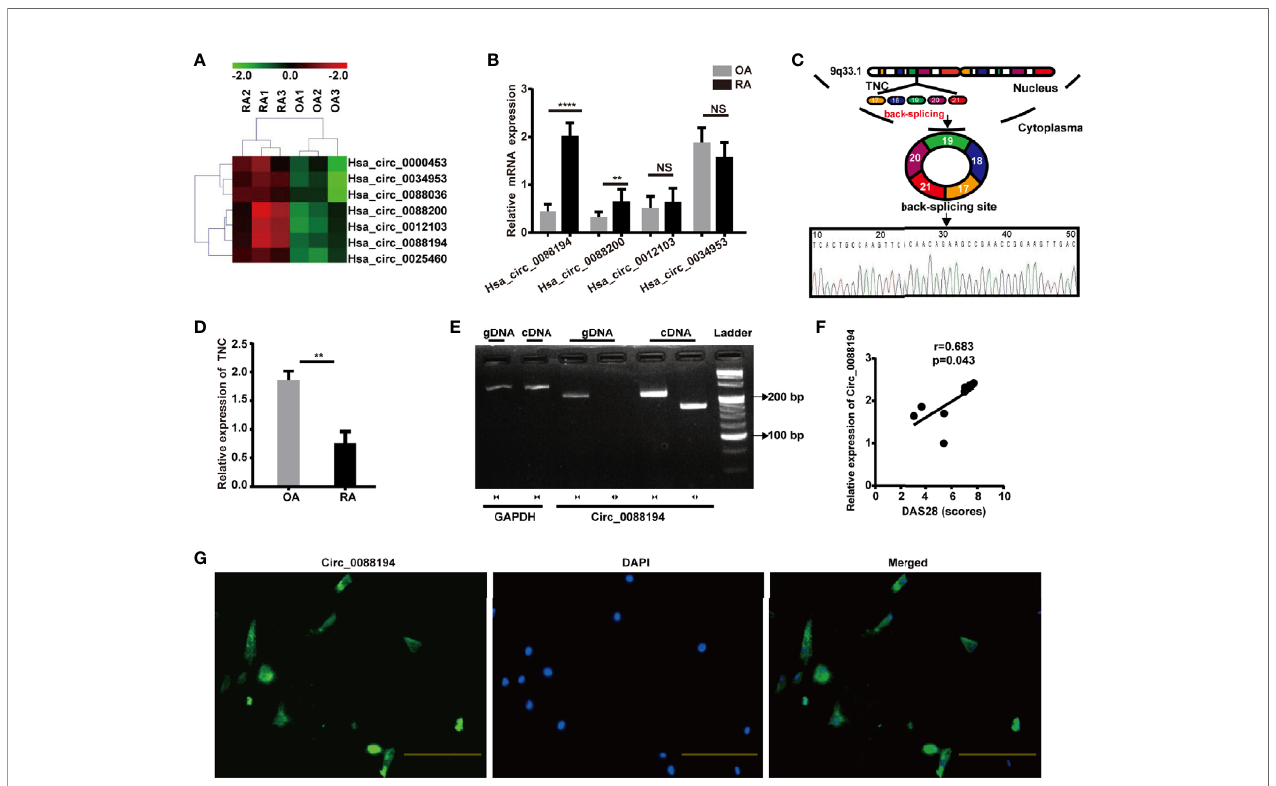
FIGURE 1 | Circ_0088194 is upregulated in RA-FLSs. (A) Hierarchical clustering analysis of differentially expressed CircRNAs between RA-FLSs and OA-FLSs. (B) QRT-PCR was used to detect the circRNA expression levels in nine RA-FLSs and seven OA-FLSs. (RA-FLSs = 9, OA-FLSs = 7). (C) Schematic illustration of how the Circ_0088194 is back-spliced from tenascin C ( TNC ) exons 17 to 21. The existence of Circ_0088194 was validated using qRT-PCR, followed by Sanger sequencing. (D) The TNC mRNA expression level, as detected using qRT-PCR in nine RA-FLSs and seven OA-FLSs. (RA-FLSs = 9, OA-FLSs = 7). (E) Divergent primers could amplify Circ_0088194 from cDNA but not from gDNA. (F) Circ_0088194 expression in RA-FLSs correlated positively with the RA disease activity score in 28 joints (DAS28 score). (n = 9; r = 0.683, P = 0.043). (G) Circ_0088194 showed a predominantly cytoplasmic localization upon RNA FISH. Scale bar, 500 µm. Data are shown as mean ± SD. NS, not signi fi cant. **indicates p < 0.01, and ****indicates p < 0.0001.